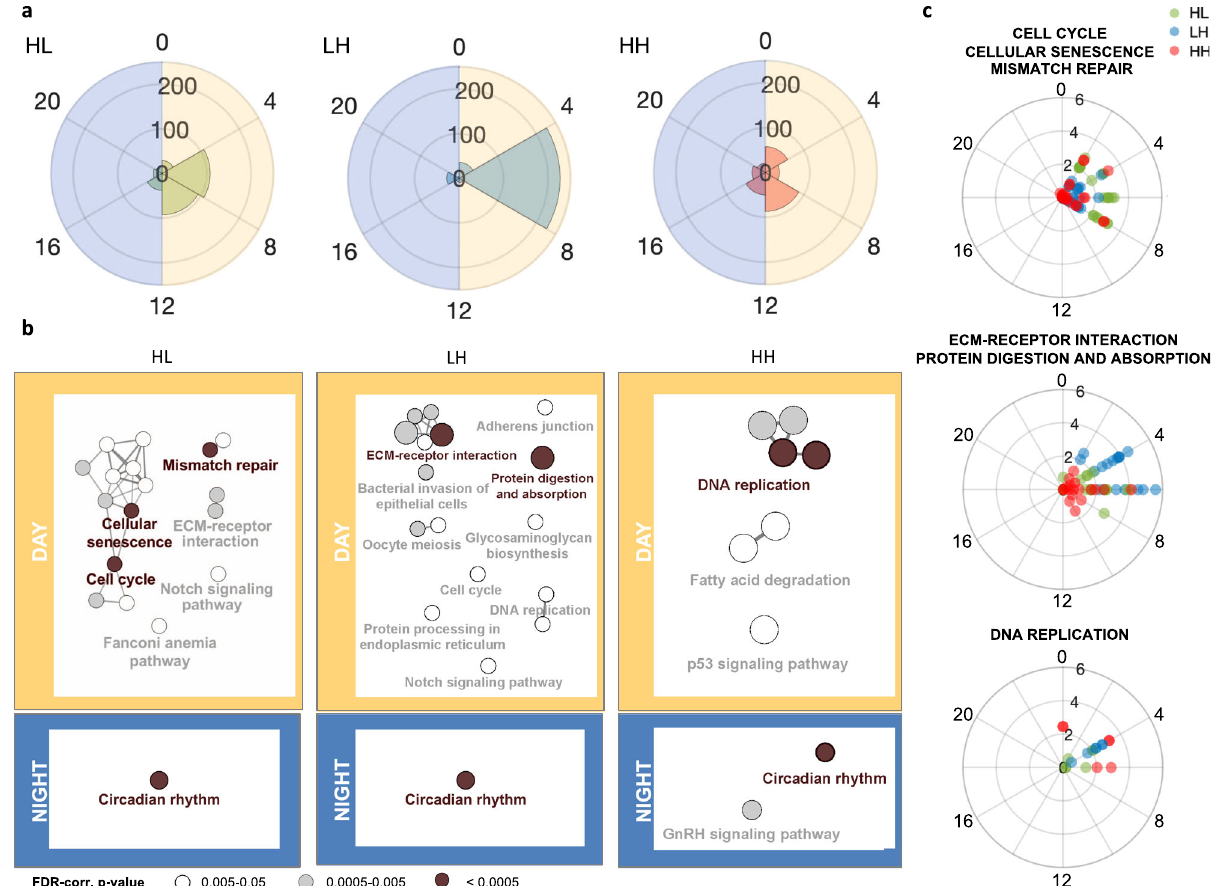
Fig. 5 Day and night entrainment of the transcriptome. a Polar diagrams of the phase distribution in HL, LH, and HH. Light = 0 – 12h, Night = 12 – 24h. b Enrichment analysis of genes oscillating in HL, LH, or HH, having their peak during the 12-h day (top) or the 12-h night (bottom), within pathways in KEGG database. c Phase and − log10( P -value) of genes belonging to the most enriched KEGG pathways during the resting phase in HL, LH, and HH,